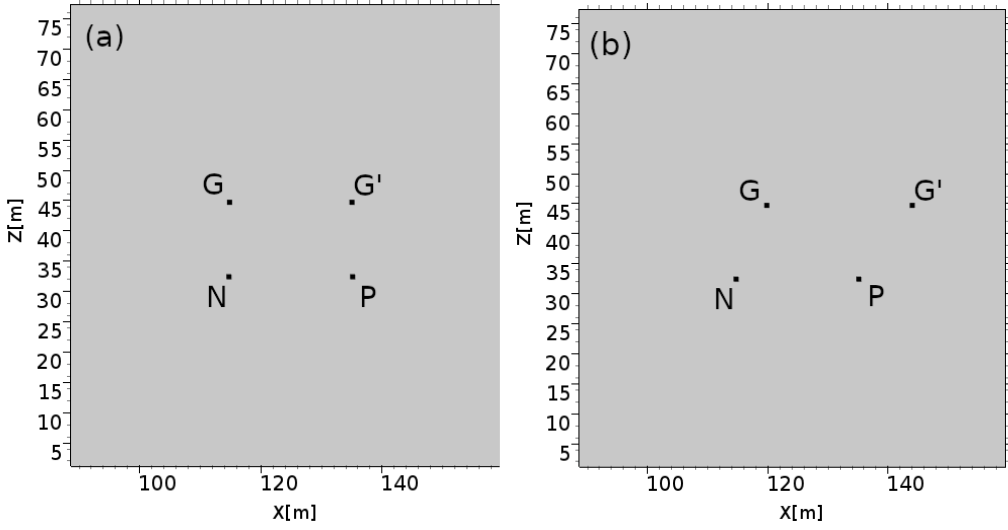
Figure 5. Cross-section of the HVDC line in the middle of the span region. G and G’ indicate the positions of the arrestor cables. N and P indicate the positions of the negative and positive poles, respectively. ( a ) Conventional topology, ( b ) Proposed topology. Arrestor cable G was shifted 5 m